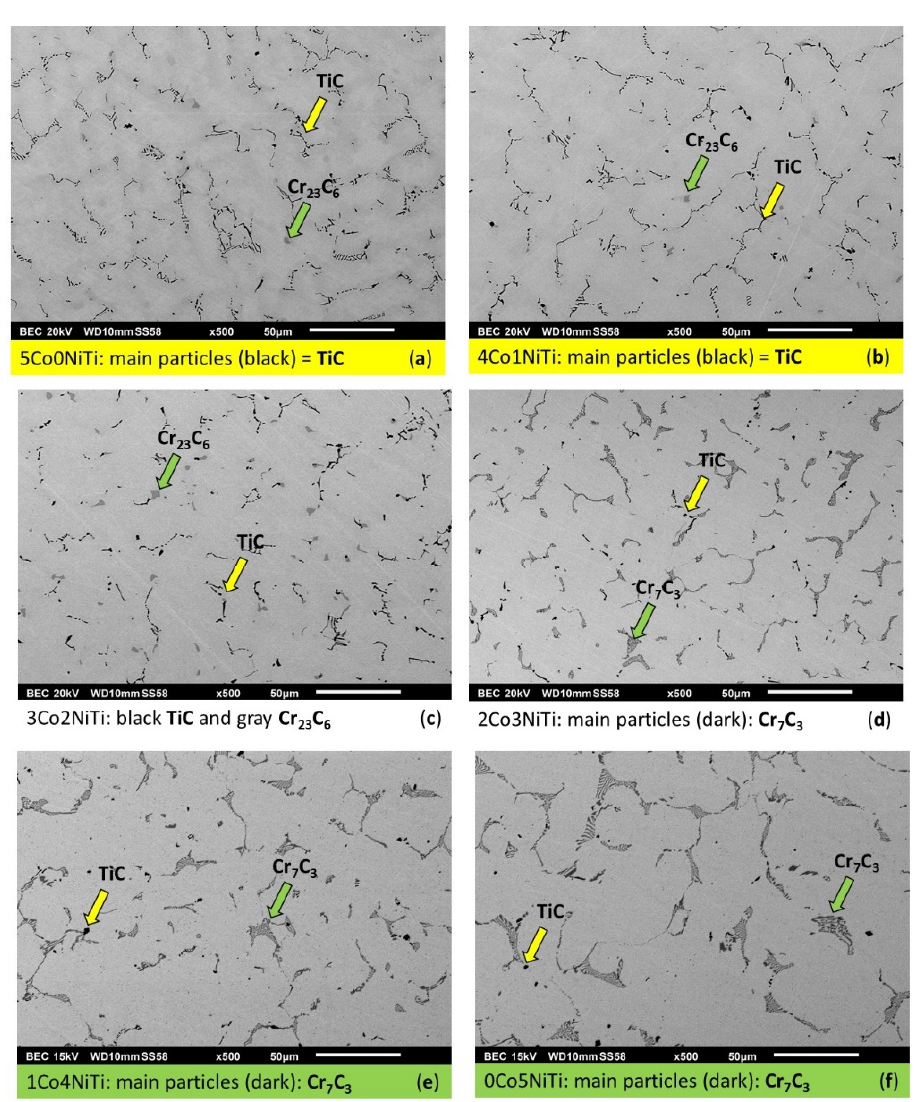
Figure 1. The as-cast microstructures of the six alloys: 5Co0NiTi ( a ), 4Co1NiTi ( b ), 3Co2NiTi ( c ), 2Co3NiTi ( d ), 1Co4NiTi ( e ) and 0Co5NiTi ( f ); SEM/BSE micrographs. Table 1. Chemical compositions of the three Co-richest alloys (confirmed by EDS full frame analysis; wt.%). Co-Based